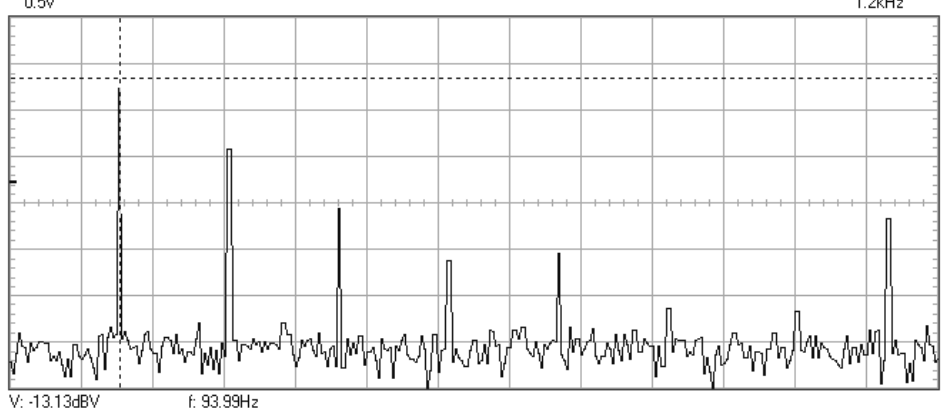
Figure 15. Amplitude spectrum recorded after 30,030 cycles at 100.1 Hz.